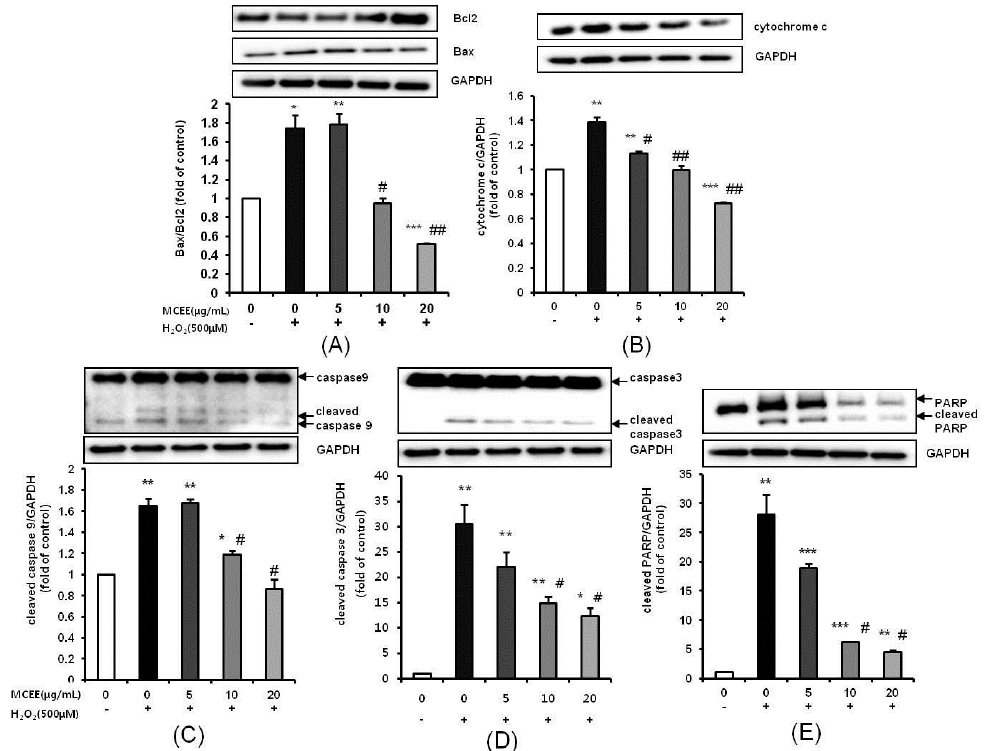
Figure 7. Neuroprotective effects of MCEE on the apoptosis-related proteins in H 2 O 2 -treated SK-N-MC cells. Cells were pretreated with the MCEE for 24 h and then treated with H 2 O 2 for 4 h. ( A ) Bax, Bcl2; ( B ) cytochrome c; ( C ) caspase-9, cleaved caspase-9; ( D ) caspase-3, cleaved caspase-3; and ( E )